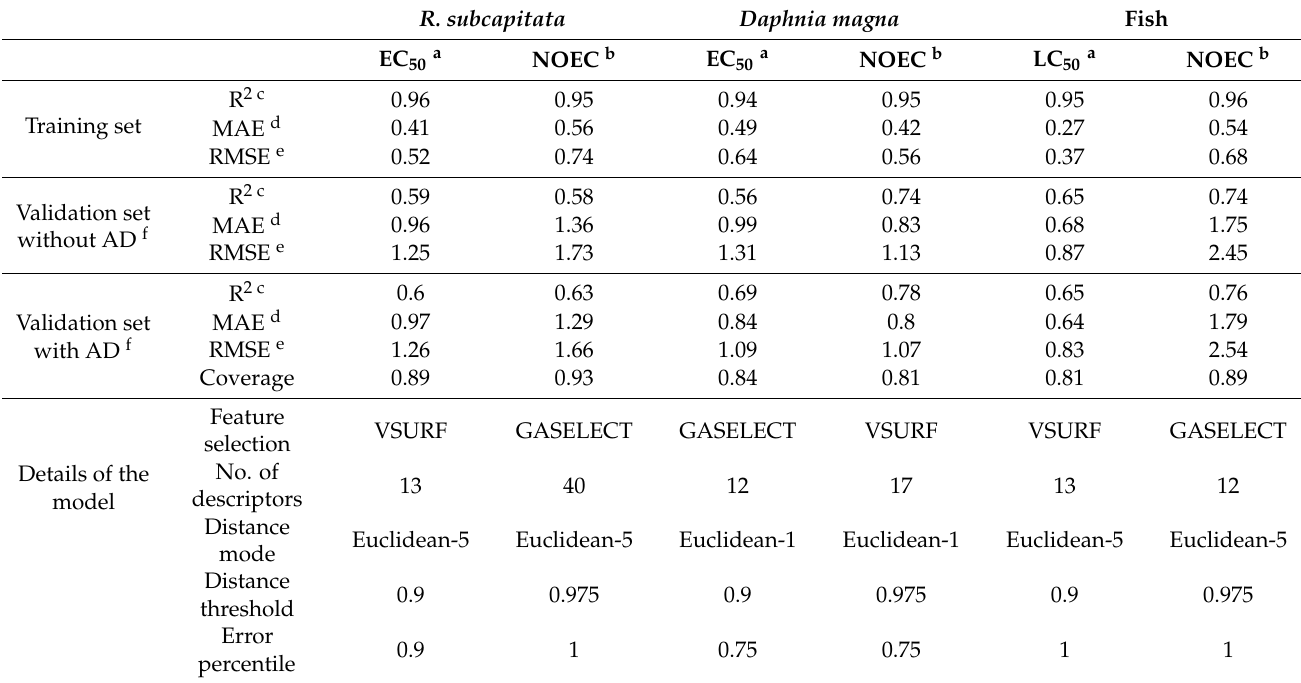
Table 1. The statistical parameters of the QSAR models on aquatic toxicity. Box-Cox transformation of millimoles per liter was used in place of the logarithm of millimoles per liter. R. subcapitata Daphnia